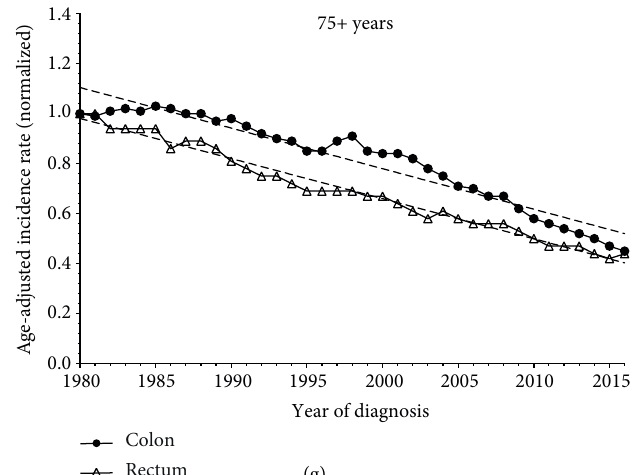
Figure 2: Comparison of normalized incidence and mortality rates between age 20–49 and 50 and older by tumor subsite, 1980–2016. Rates of individuals age 20–49 and 50 and older from 1980–2016 from SEER9 were normalized to the 1980 rate to better visualize the magnitude of differences in incidence and IBM trends by age over time. Normalized rates were divided into 10-year age intervals: 20–29 (a), 30–39